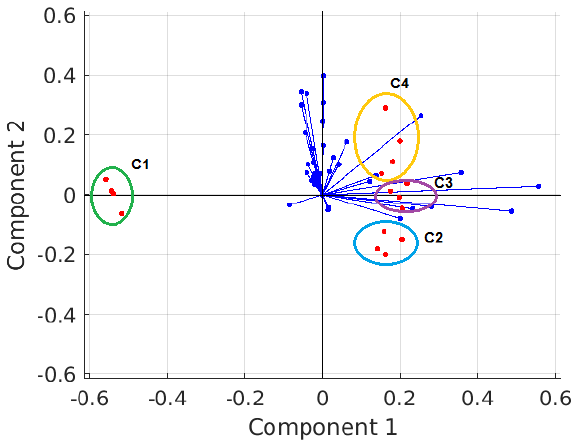
Figure 6. Biplot of the PCA with observations.